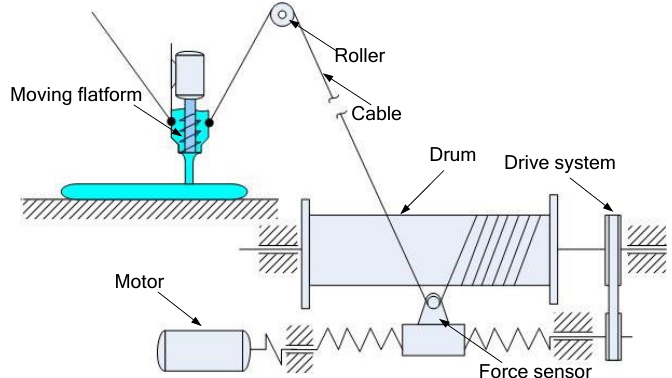
Figure 11. Cable winch diagram.